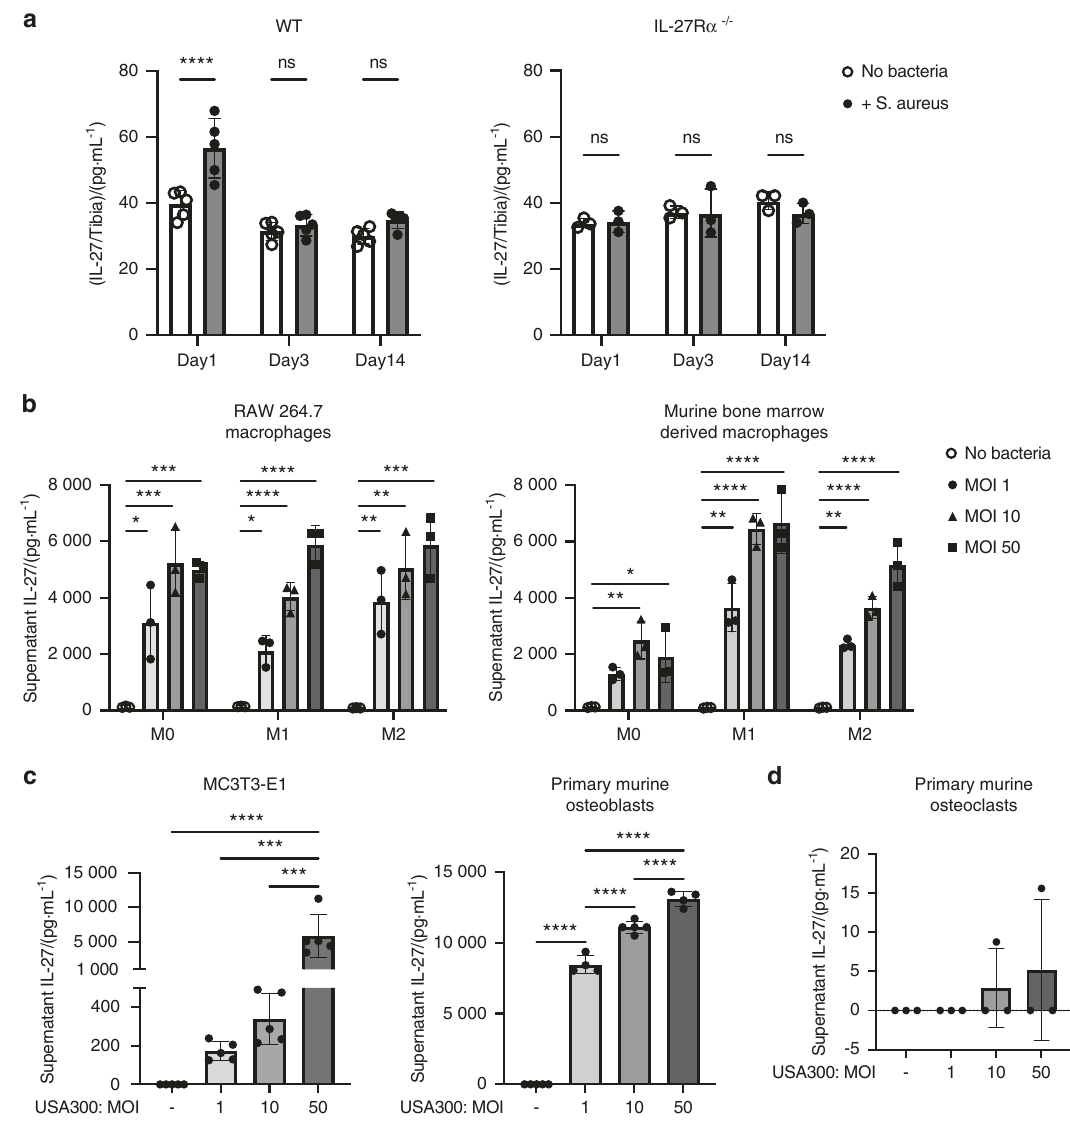
Fig. 2 Early autoregulation of IL-27 at the infection site and evidence of MRSA-induced secretion of IL-27 by macrophages and osteoblasts but not by osteoclasts. a Female WT and IL-27R α − / − mice ( n = 3 – 5) were challenged with a sterile or a MRSA (USA300 LAC::lux)-contaminated transtibial implant, and the infected tibiae were harvested at the indicated times to measure IL-27 protein levels in bone tissue homogenates via ELISA. b Cultured RAW264.7 cells and primary murine bone marrow-derived macrophages differentiated with PBS, IFN- γ (50 ng·mL − 1 ) or IL-4 (20 ng·mL − 1 ) to generate M0, M1 and M2 macrophages, respectively, were exposed to S. aureus USA300 for 24 h (MOI = 1, 10, 50). Subsequently, culture supernatants were collected and assessed for IL-27p28 via ELISA. c Cultured murine calvarial MC3T3-E1 osteoblasts and primary bone marrow-derived osteoblasts were exposed to S. aureus USA300 for 24 h (MOI = 1, 10, 50), and culture supernatants were assessed for IL-27 via ELISA. d Cultured murine primary bone marrow-derived osteoclasts were exposed to S. aureus USA300 (MOI = 1, 10, 50), and supernatants were assessed for IL-27p28 via ELISA. The data from each experiment are presented with the mean ± SD for the group ( n = 3 – 5) (* P < 0.05, ** P < 0.01, *** P < 0.001 **** P < 0.000 1,